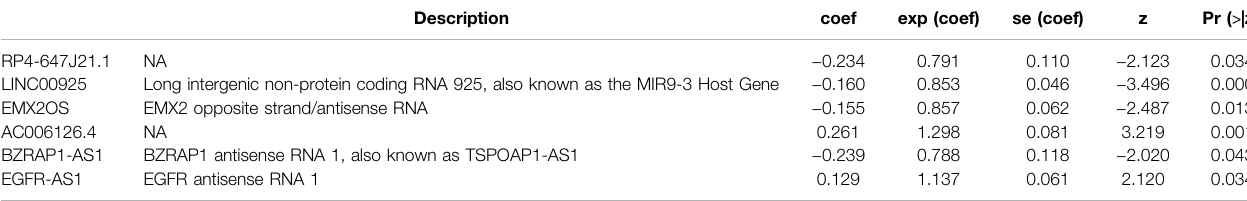
TABLE 1 | Results of hub lncRNAs based on TCGA TARGET GTEx data after the multivariate Cox regression.